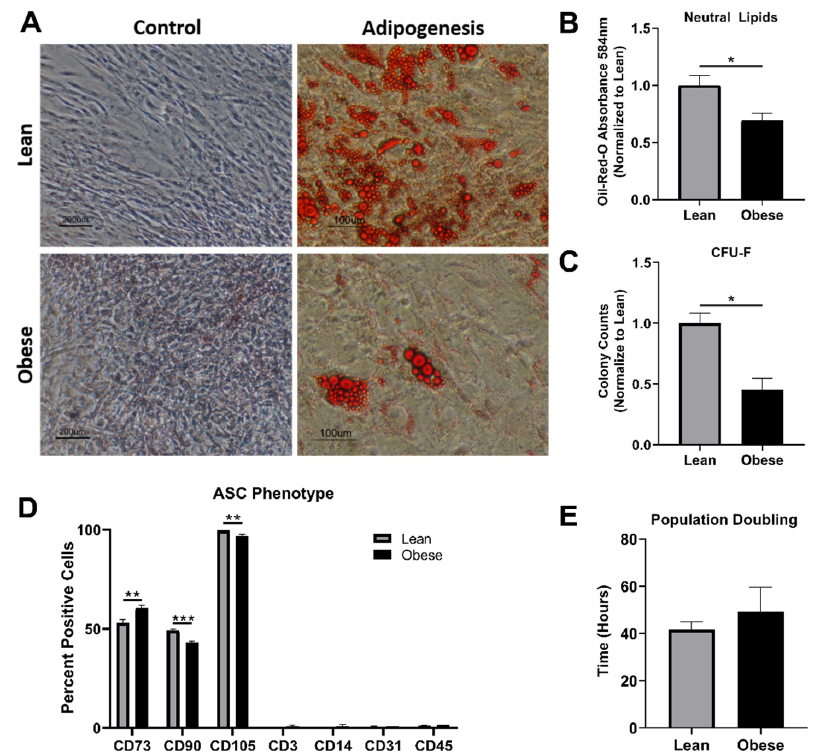
Figure 1. Pooled ObASCs exhibit reduced stemness characteristics. ( A ) LnASCs and ObASCs were differentiated with adipogenic media for 21 days and stained with Oil-Red-O and imaged at 10× (scale bar is 200 μ m for controls and 100 μ m for adipogenesis). ( B ) Oil-Red-O destaining absorbance was measured at 584 nm and normalized to the LnASCs. ( C ) CFU-F assay was completed with both LnASCs and ObASCs and the results were normalized to the LnASC colony counts. ( D ) Flow cytometry analysis of LnASCs and ObASCs using both positive and negative MSC markers. ( E ) Average population doubling time of LnASCs and ObASCs expressed in hours. Values are presented as means (N = 3) ± SD of three independent experiments using Mann-Whitney tests. Statistical differences between the means are marked with * p < 0.05, ** p < 0.01, *** p < 0.001. Abbreviations: LnASCs, lean ASCs; ObASCs obese ASCs; CD, cluster of